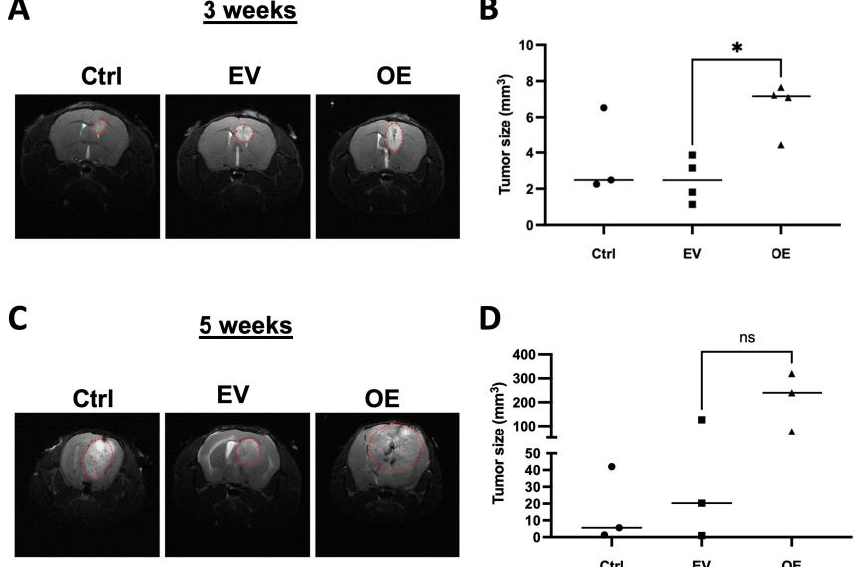
Figure 6. Overexpression of TCF12 in tumor cells leads to more aggressive tumors in vivo. ( A ) T2 coronal MRI images of whole brain at 3 weeks post-injection of mice that were injected with control GL261 cells (Ctrl), GL261 cells that received empty vector (EV), GL261 cells overexpressing TCF12 (OE). ( B ) Tumor sizes measured on MRIs of whole brain at 3 weeks post-injection of mice injected with Ctrl, EV, and OE GL261 cells. ( C ) T2 coronal MRI images of tumor mice at 5 weeks post-injection of control, scramble, and TCF12 KO GL261 tumor bearing mice. ( D ) Tumor sizes measured on MRIs at 5 weeks post-injection of Ctrl, EV, and OE GL261 tumor bearing mice. ns not significant; * p < 0.05 ( B , D ). Circles: mice recipient of scramble tumor cells; triangles: mice recipient of TCF12 Ko tumor